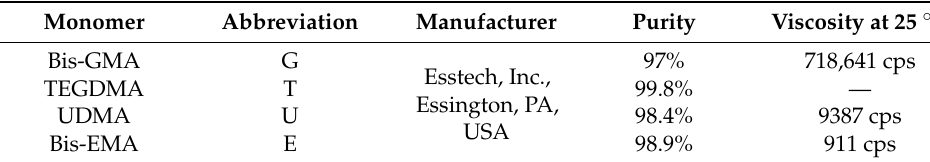
Table 2. Monomers used in the study.